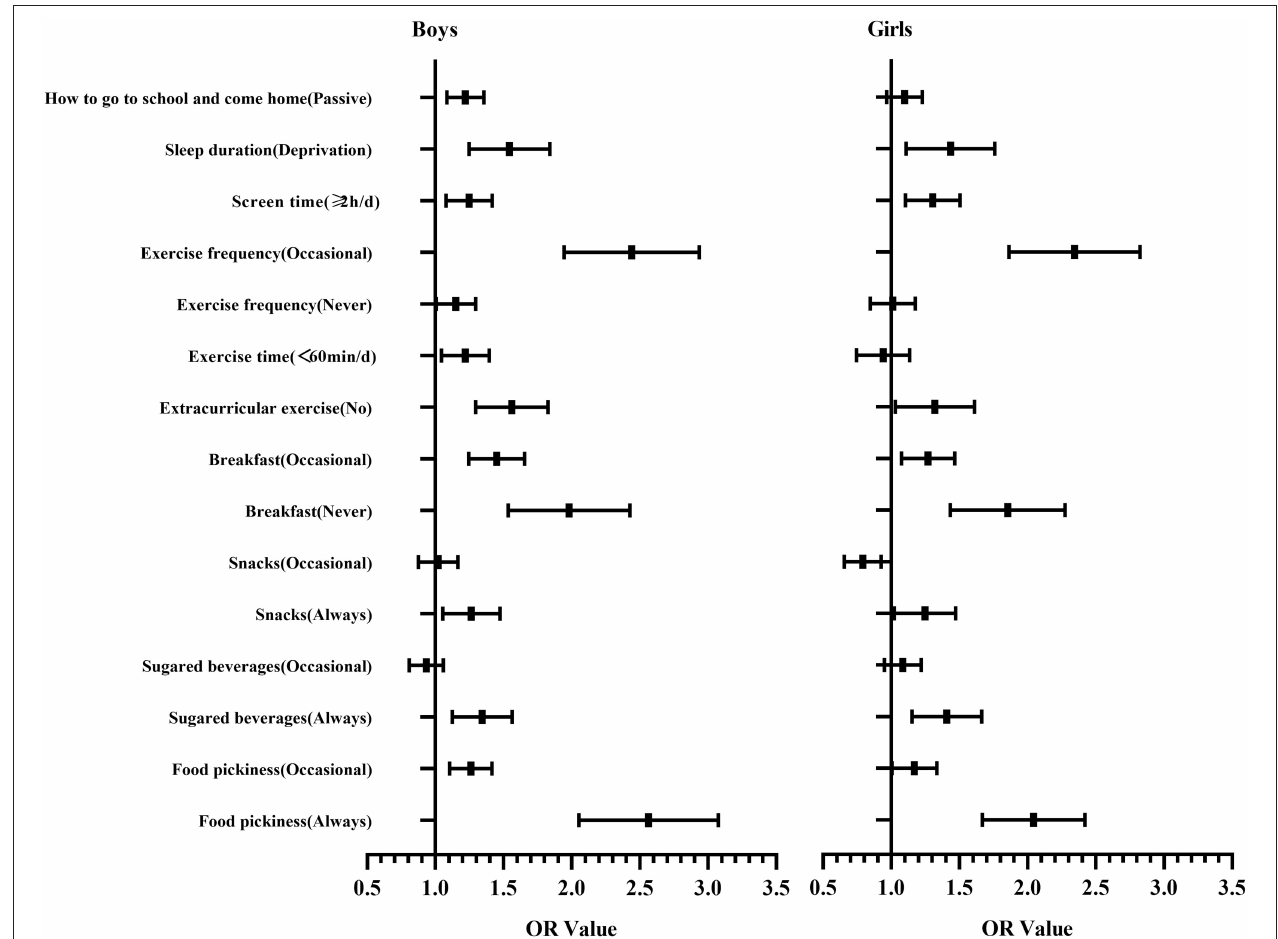
FIGURE 2 | The diagram of the OR value (95% CI) of regression analysis on the correlation between psychological symptoms and lifestyles for boys and girls,